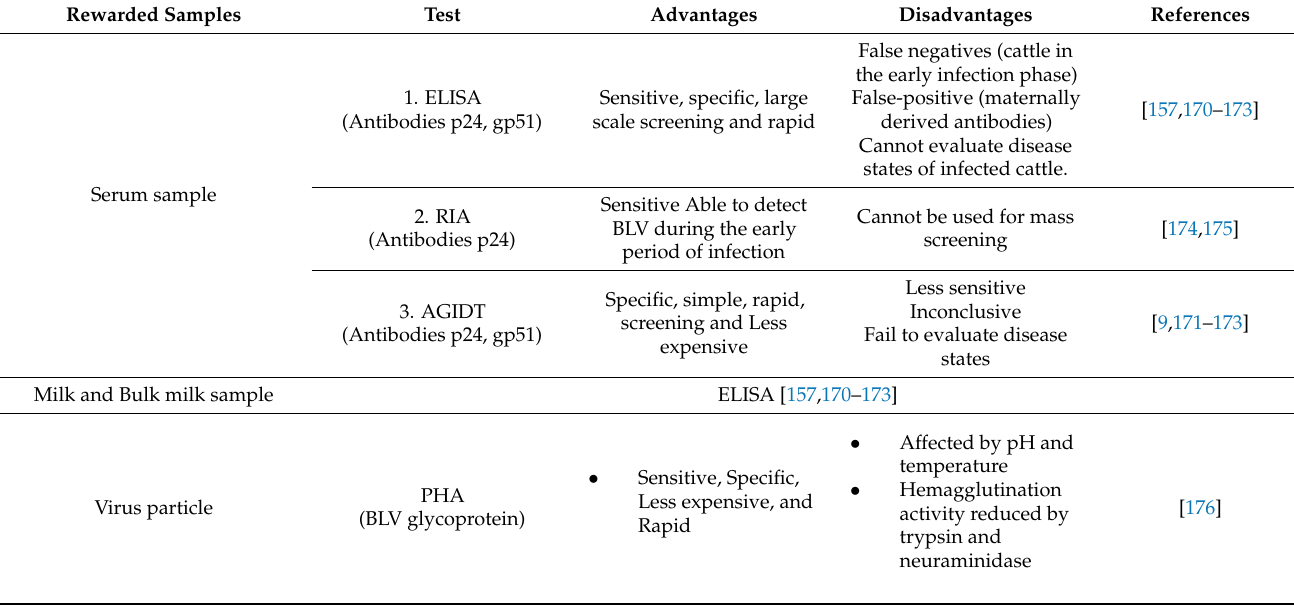
Table 3. Serological techniques used for diagnosis of BLV prevalence according to the rewarded samples and test sensitivity, reproduced from [58].